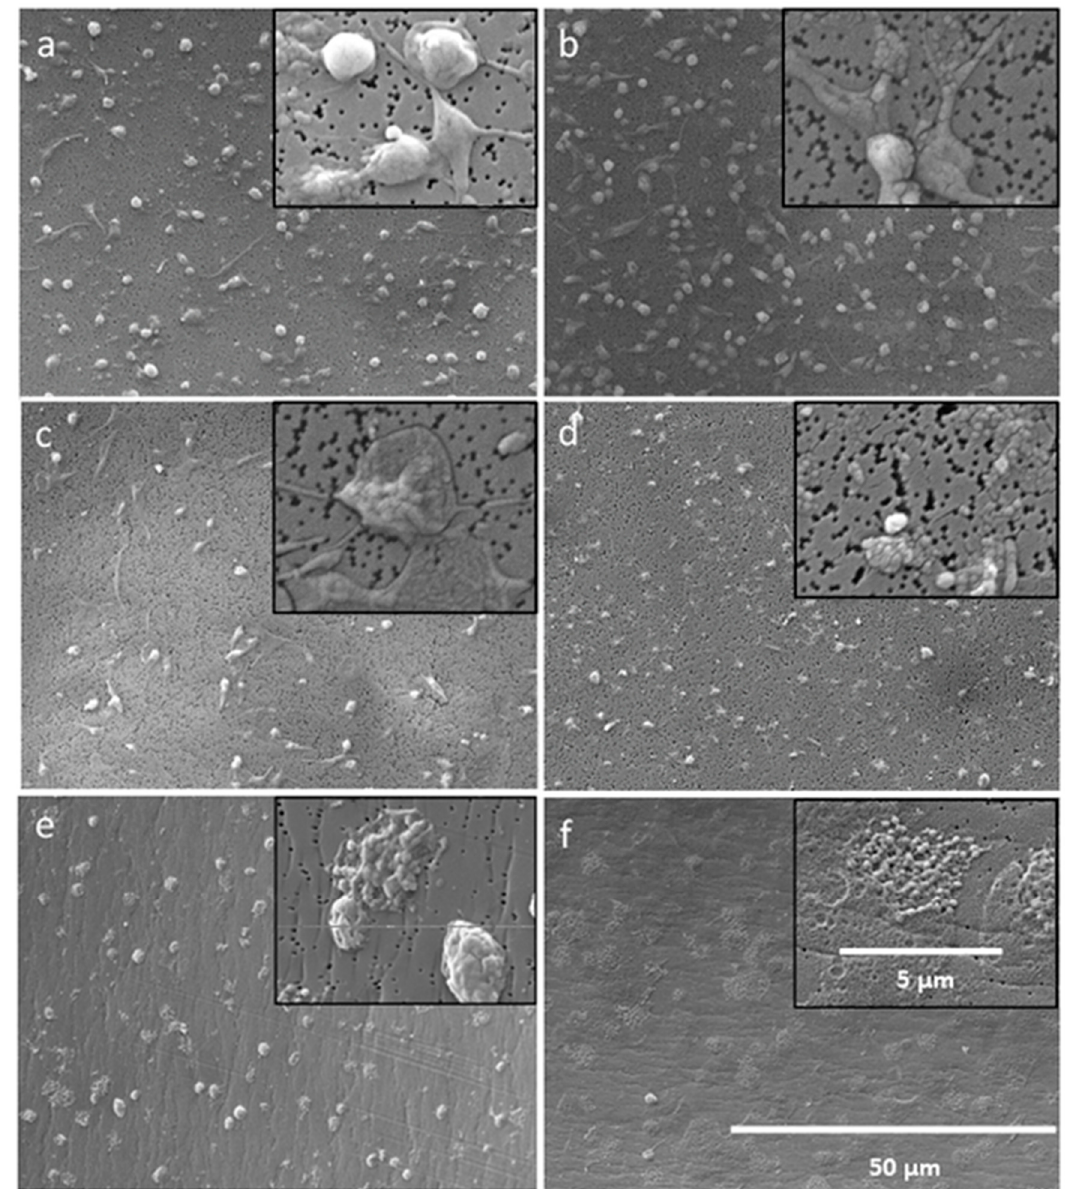
Figure 7. SEM imaging of platelets from citrate anticoagulated PRP incubated without AMPs ( a ), with 128 µ g / mL PMB ( b ), with 128 µ g / mL 322-NH2 ( c ) and with 128 µ g / mL 322-C 14 ( d ). SEM imaging of platelets from heparin anticoagulated PRP incubated with 128 µ g / mL LL-37 ( e ) and with 128 µ g / mL LF11-227-C 14 ( f ).